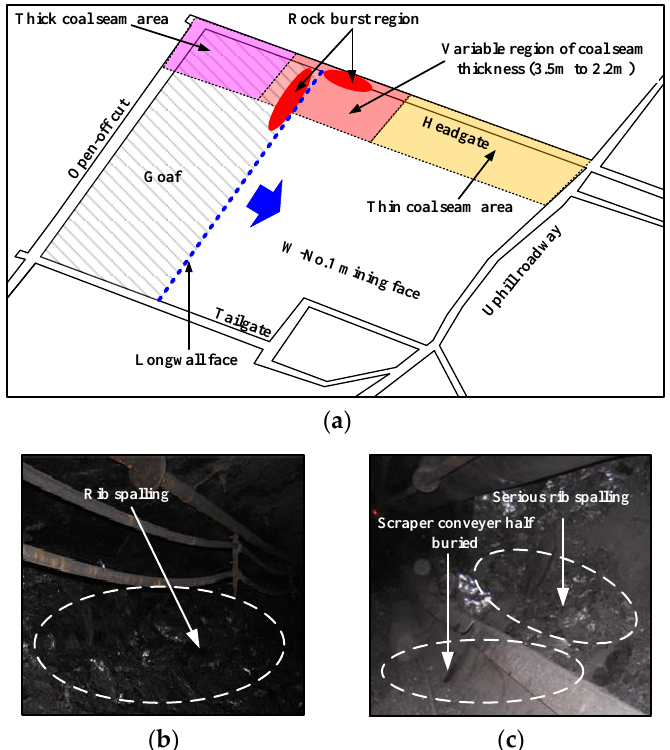
Figure 2. Rock burst region in the W-No. 1 mining face and photos of the rock burst damage, ( a ) rock burst region, ( b ) roadway damage, ( c ) longwall face damage.